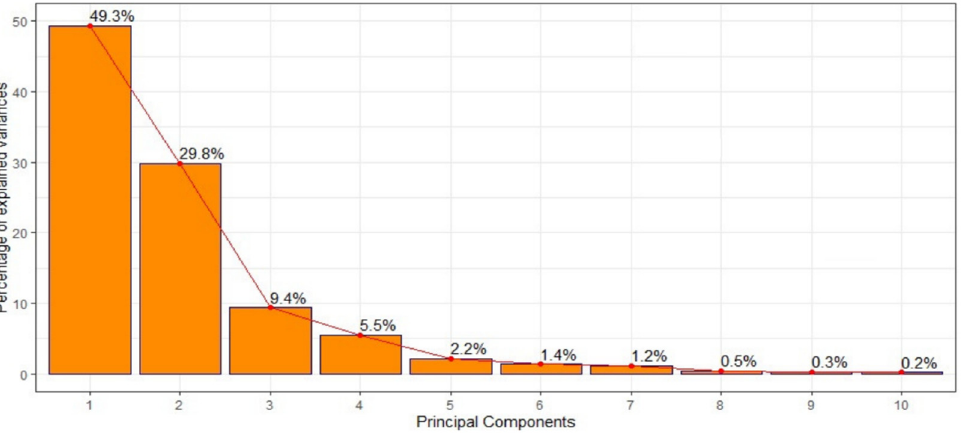
Figure 2. Percentage of inertia, explained by the synthetic indicators in principal component analy- sis. Table 1. Correlation of the main synthetic indicators with malaria incidence. Synthetic Variables Indicators